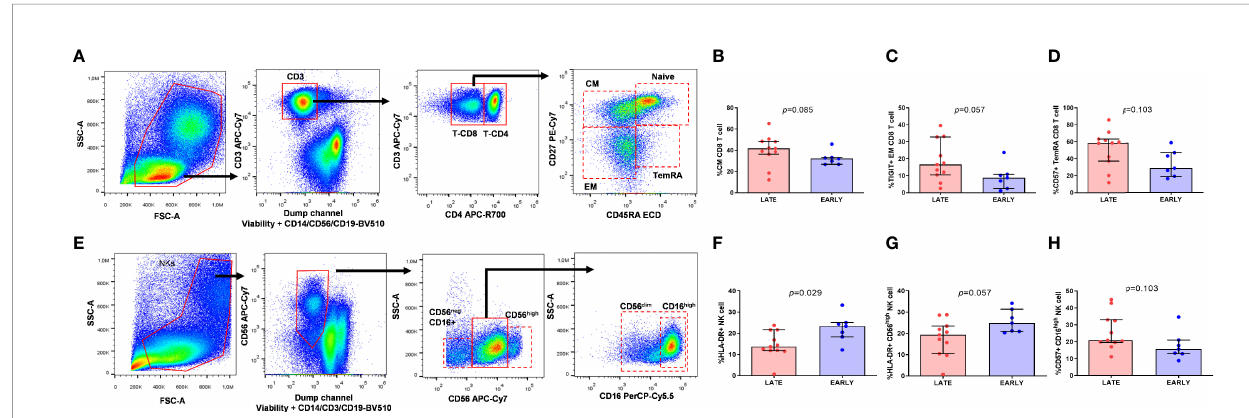
FIGURE 3 | Memory CD8-T cell distribution and activation and exhaustion expression markers on CD8-T cell subsets and NK cell subsets from HIV-infected young adults. Gate strategy for memory subset distribution on T cell (A) , lymphocytes were characterized by the patterns of forward and side scatter, followed by selection of CD3+. Central Memory (CM) (CD45RA-CD27+) CD8 T cell subset distribution (B) , TIGIT expression on Effector Memory (EM) (CD45RA-CD27-) CD8 T cell subset (C) and CD57 expression on Terminally Differentiated (TemRA) (CD45RA+CD27-) CD8 T cell subset (D) . Gate strategy for NK cell subsets (E) viable cells, negative for CD3, CD14 and CD19 were classi fi ed in three subsets according to the expression of CD56 and CD16. HLA-DR expression on total NK cells (F) and CD56 high (G) NK cell subset and CD57 expression on CD16 high NK cell subset (H) from EARLY treated group (n=7) and LATE treated HIV-1-young adults (n=11). Mann- Whitney U test was